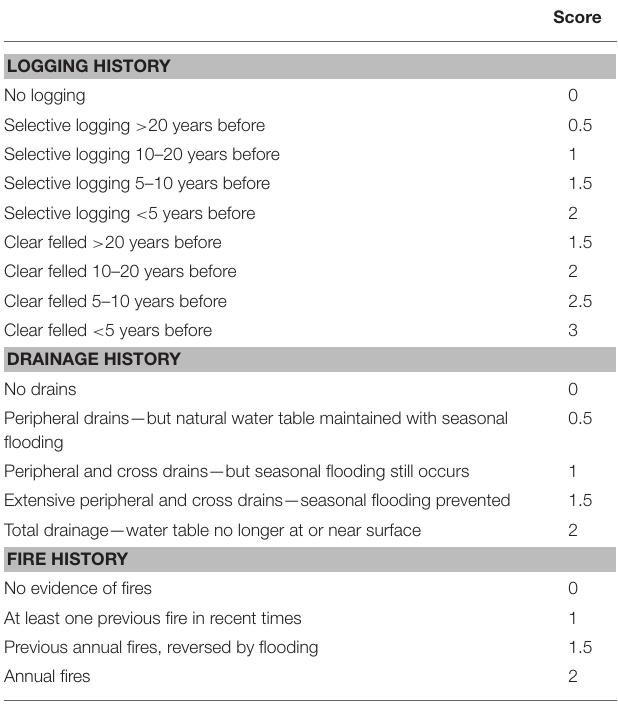
TABLE 1 | Evaluation of peatland degradation based on logging, drainage and